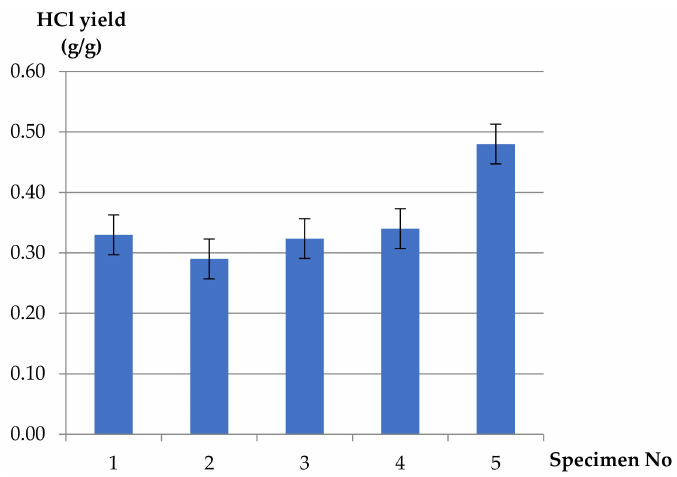
Figure 9. HCl yields (mass loss basis) for H07V-U cable and pure PVC polymer at di ff erent ventilation